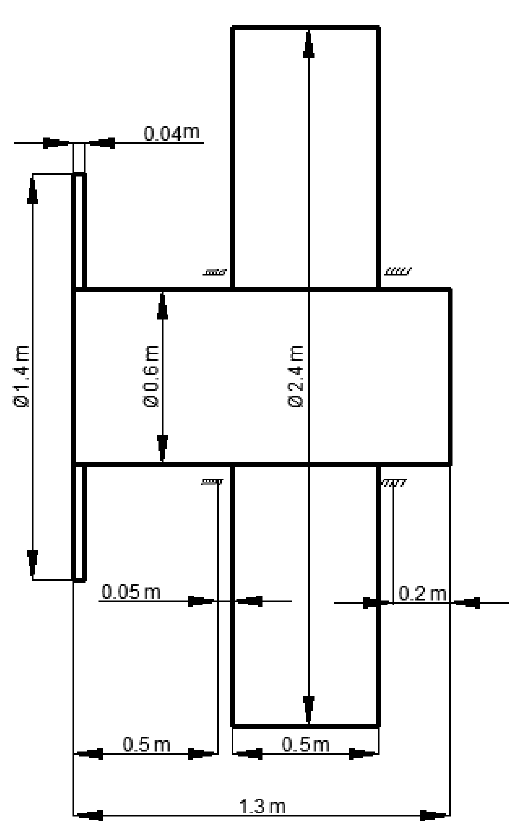
Figure 4. Structural parameter of the motorized spindle-tool sys-